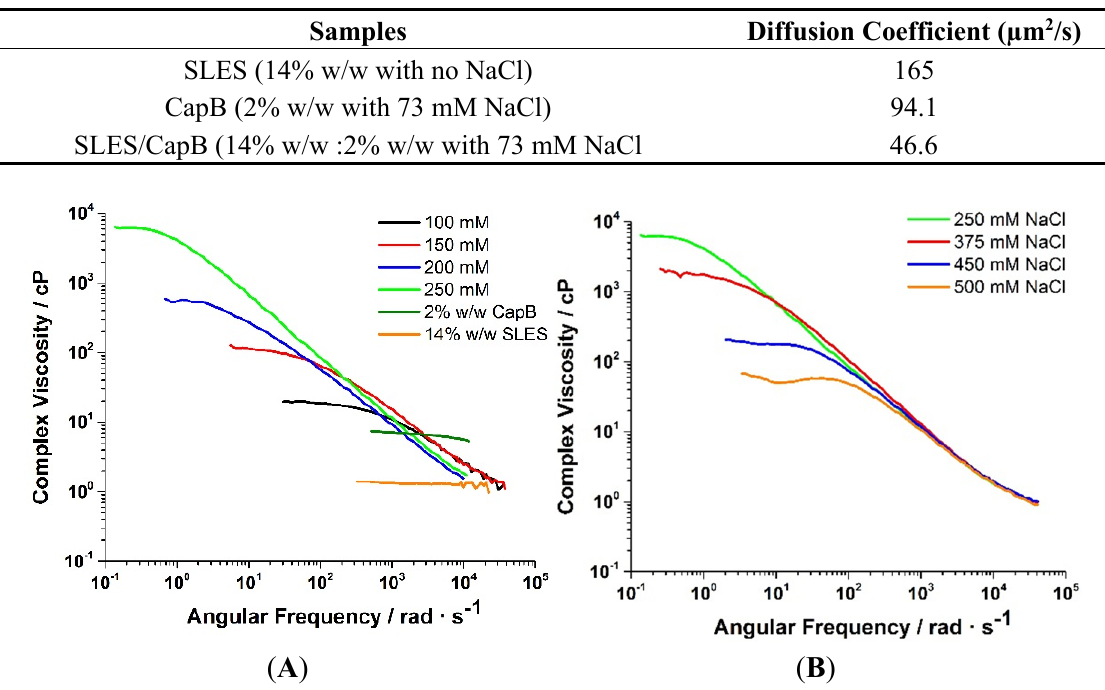
Figure 2. ( A ) Viscosity enhancement and evolution of non-Newtonian behavior for a mixed SLES/CapB system with changing salt concentration; ( B ) Decreasing viscosity while maintaining non-Newtonian behavior after peaking at 250 mM NaCl. 250 mM NaCl is shown in both figures as a point of